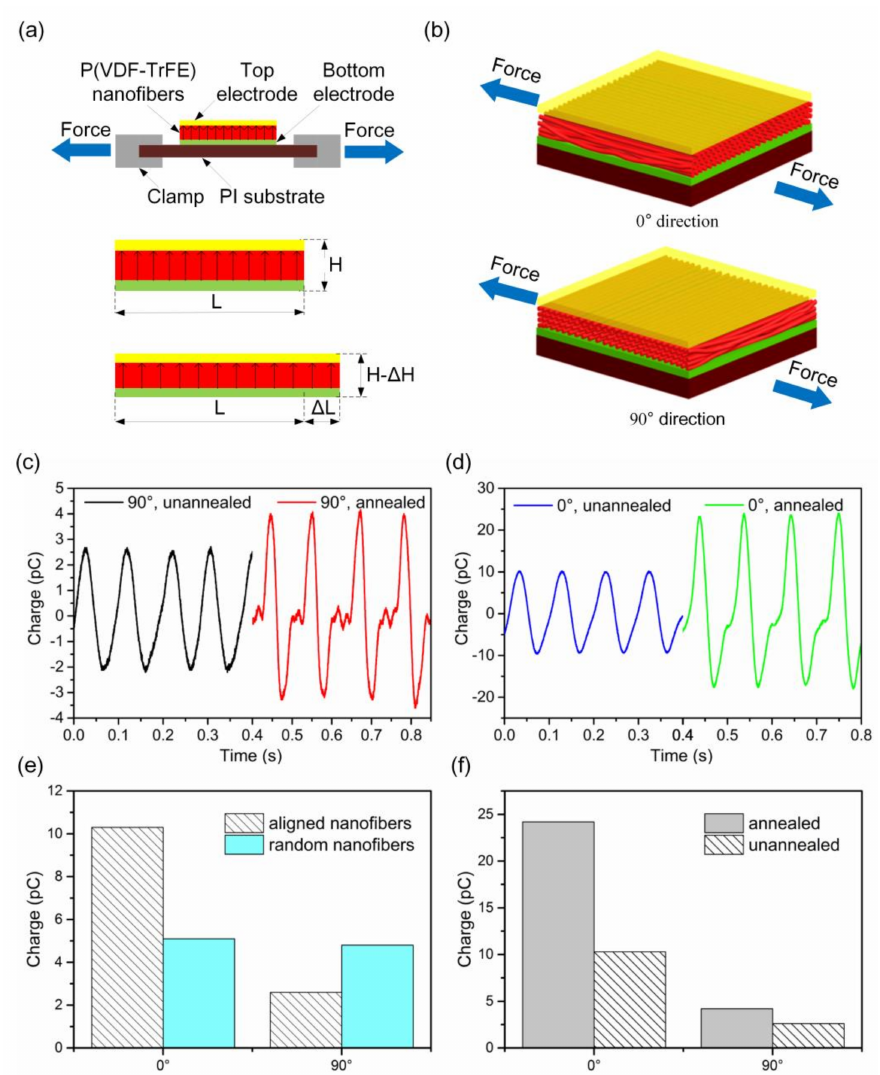
Figure 5. Directional strain sensing measurements using the P(VDF-TrFE) nanofiber mat. ( a ) Cross-sectional view and ( b ) t op view of the measurement setup. ( c ) Piezoelectric charge outputs with alternating strain in the 90 ◦ direction. ( d ) Piezoelectric charge outputs with alternating strain in the 0 ◦ direction. ( e ) Piezoelectric charge outputs for devices with aligned and random nanofibers that stretched in 0 ◦ and 90 ◦ directions, indicating directional sensing ability of well-aligned nanofibers. ( f ) Piezoelectric charge outputs for devices with annealed and unannealed nanofibers that stretched in 0 ◦ and 90 ◦ directions, indicating enhanced piezoelectric response due to annealing